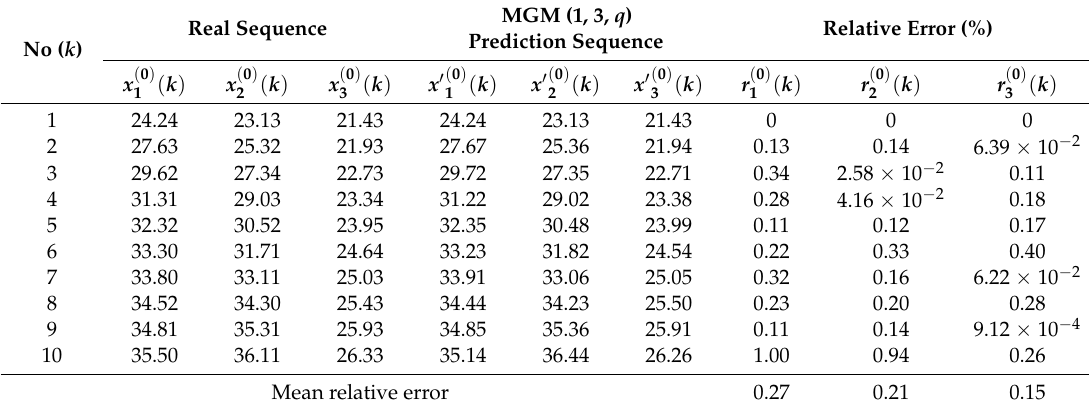
Table 2. MGM (1, 3) model fitting value and error analysis.